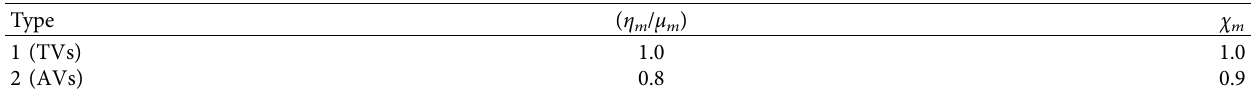
Table 2: Parameters of vehicle types.